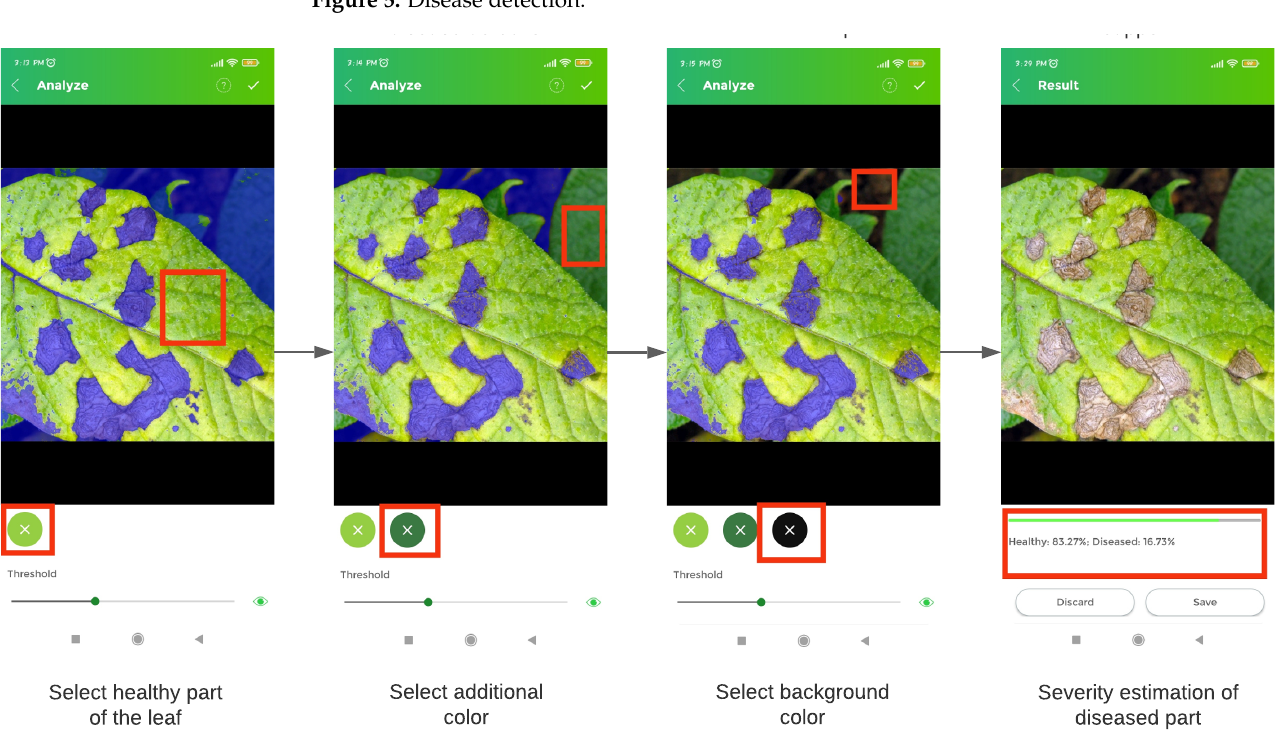
Figure 5. Disease detection.